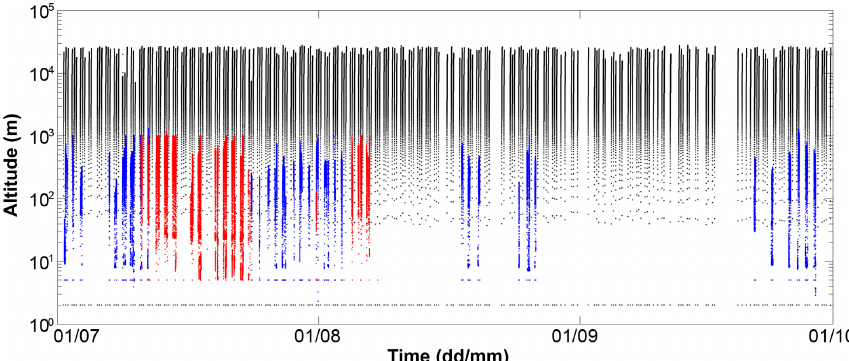
Figure 6. A time–height cross section illustrating all of the POPEYE radiosonde launches (black dots), DataHawk2 flights (red dots) and tethered balloon flights (blue